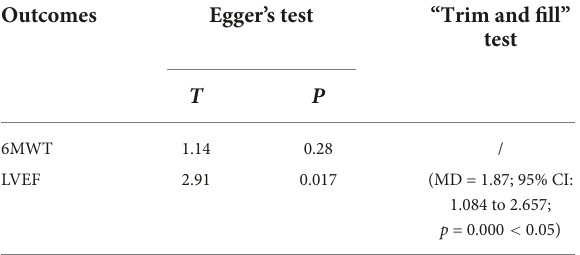
TABLE 2 The results of publication bias and “trim and fill” test.